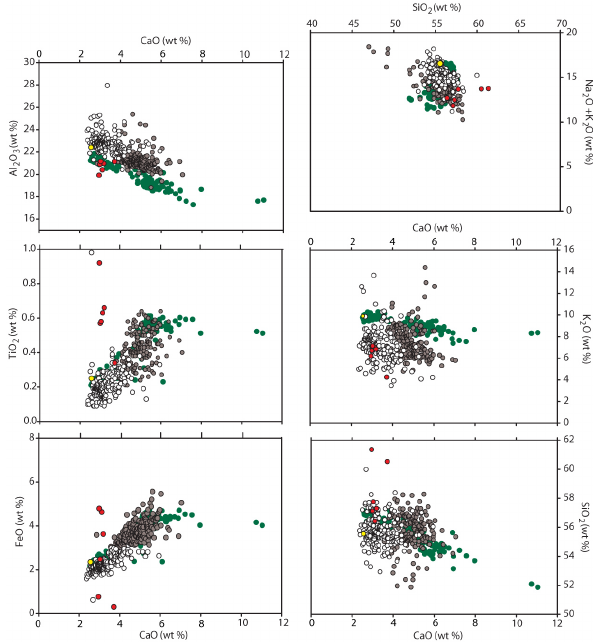
Fig. 5. Biplots comparing the chemical composition of the tephra